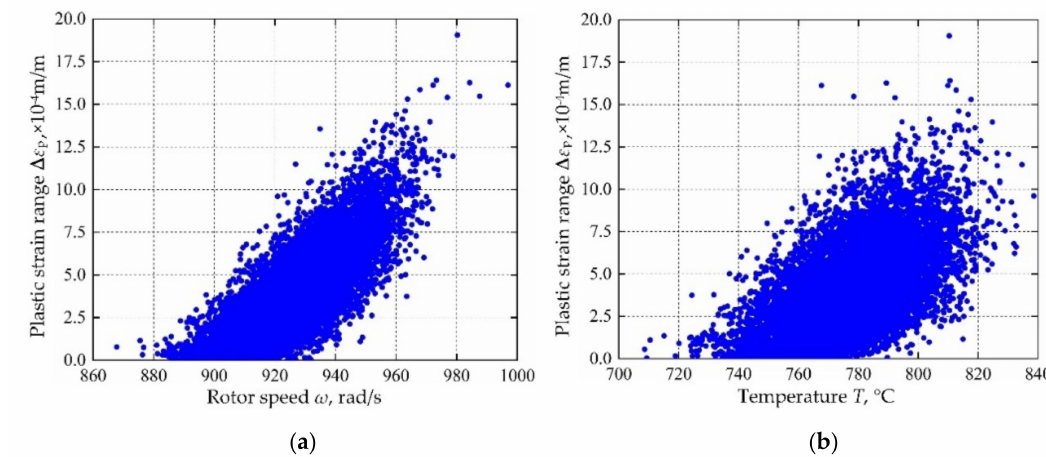
Figure 16. Scatter sketches of plastic strain range: ( a ) rotor speed, ( b )